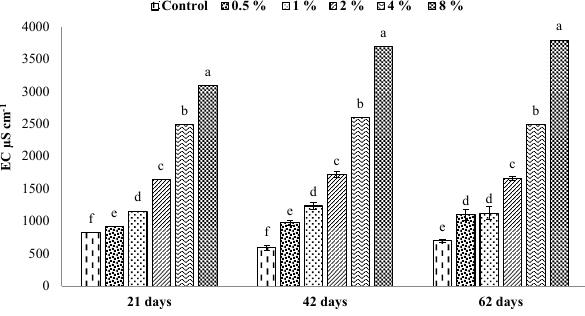
Table 2. Properties of the SMC.